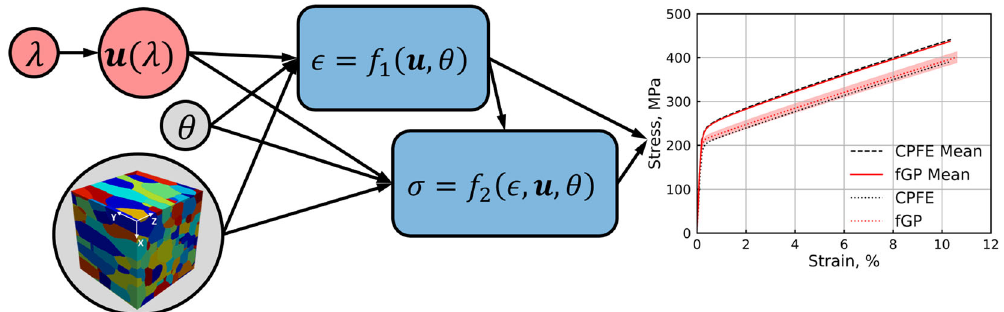
Fig. 1 fGP graphical network. A functional Gaussian process graphical network, which uses a loading parameter ( λ ), displacement ( u ), constitutive model parameters ( θ ), and the microstructure morphology to predict stress ( σ ) and strain ( ϵ ) in each grain and a mean response over a whole RVE.